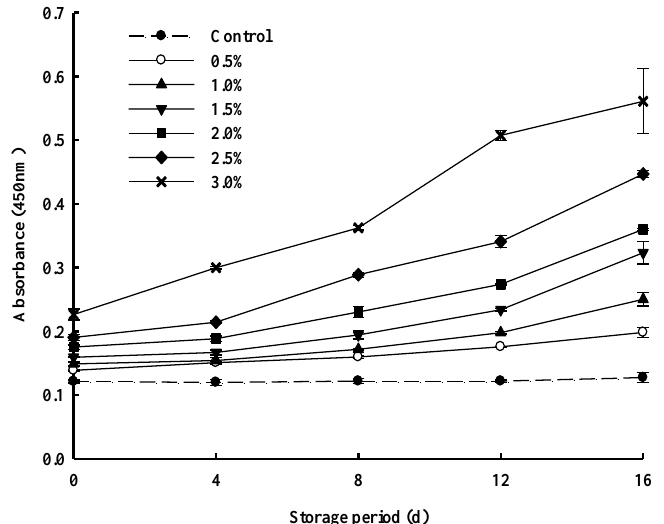
Figure 4. Changes in thiobarbituric acid reactive substance (TBARS) value of powdered peanut sprout extract microcapsule- supplemented milk stored at 4  C for 16